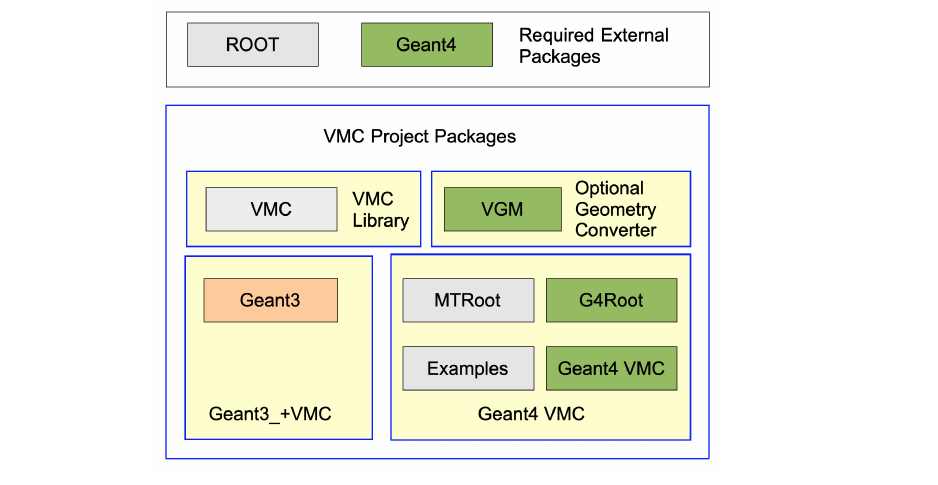
Figure 1. VMC Project Packages